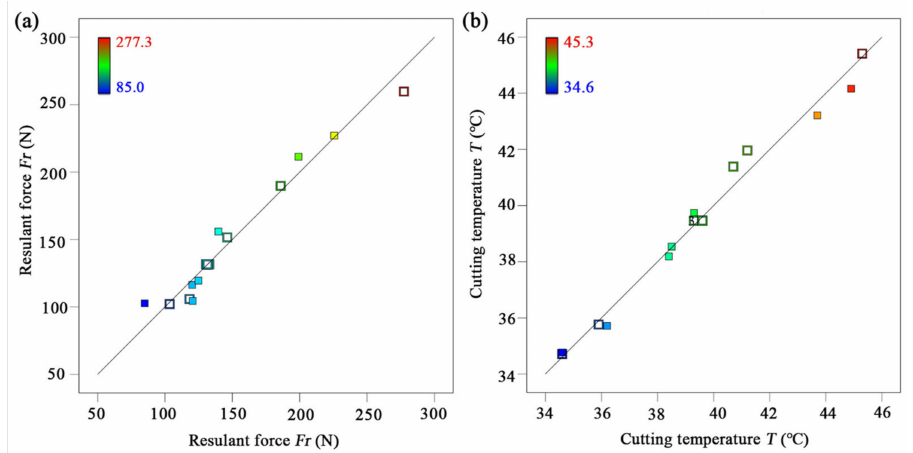
Figure 2. ( a ) Actual and predicted values for resultant force; ( b ) Actual and predicted values for cutting temperature.